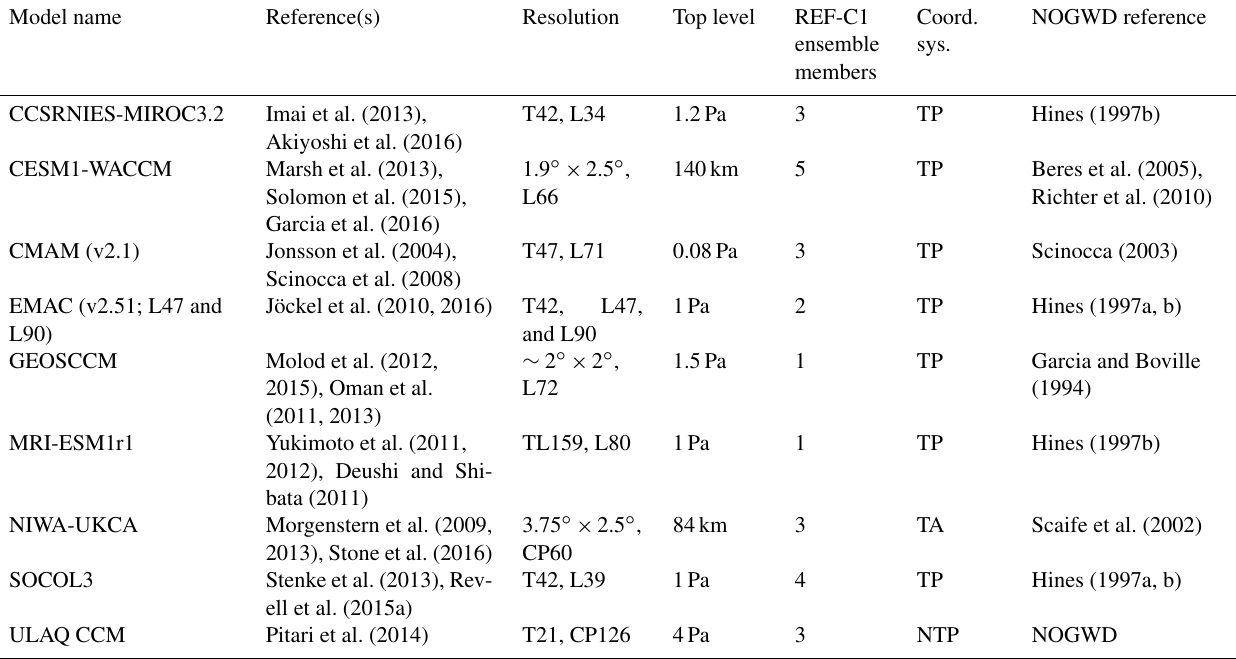
Table 1. CCMI models that provided TEM diagnostic model output used in this study. CP is Charney–Phillips, T21 ≈ 5.6 ◦ × 5.6 ◦ , pressure, and NTP is non-terrain-following pressure.